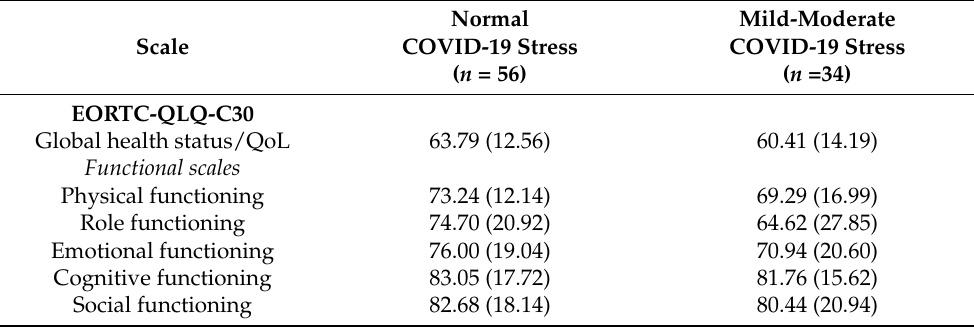
Table 3. Means and standard deviations of EORTC-QLQ-C30 and HADS scores according to COVID- 19 stress